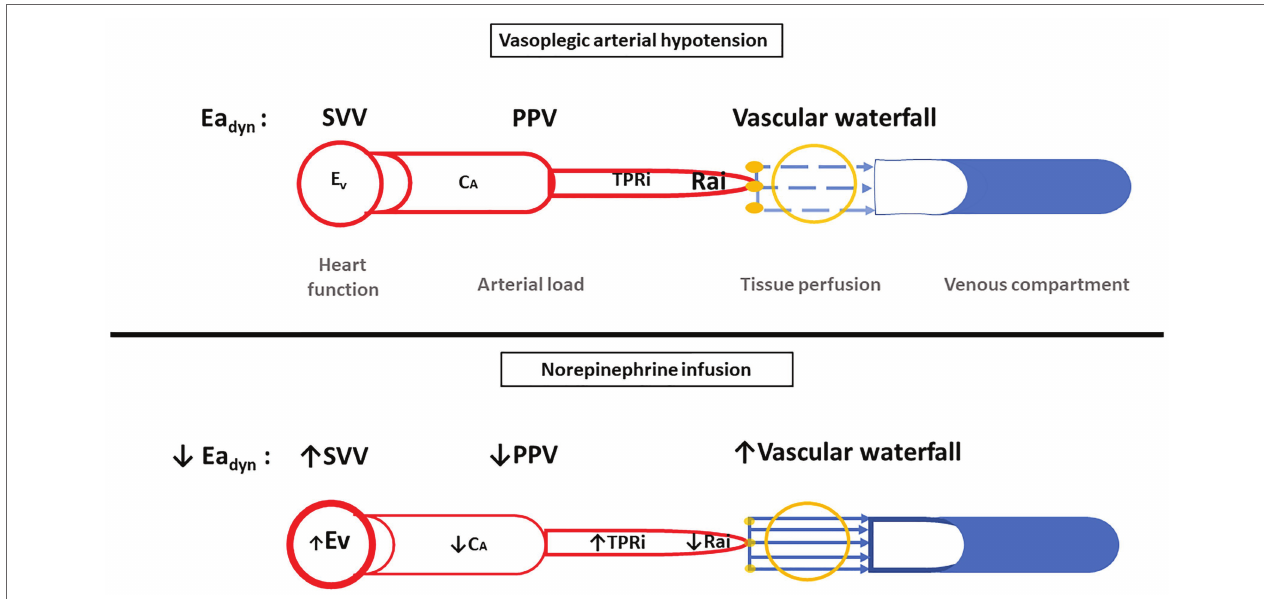
FIGURE 3 | Illustration of the evolution of parameters in cases of vasoplegic arterial hypotension and in case of norepinephrine infusion. C A , arterial compliance; CCP, critical closing pressure; E A , arterial elastance; Ea dyn , dynamic arterial elastance; E V , ventricular elastance; PPV, pulse pressure variation; TPRi, indexed total peripheral resistance; Rai, resistance arterial indexed; SVV, stroke volume variation.